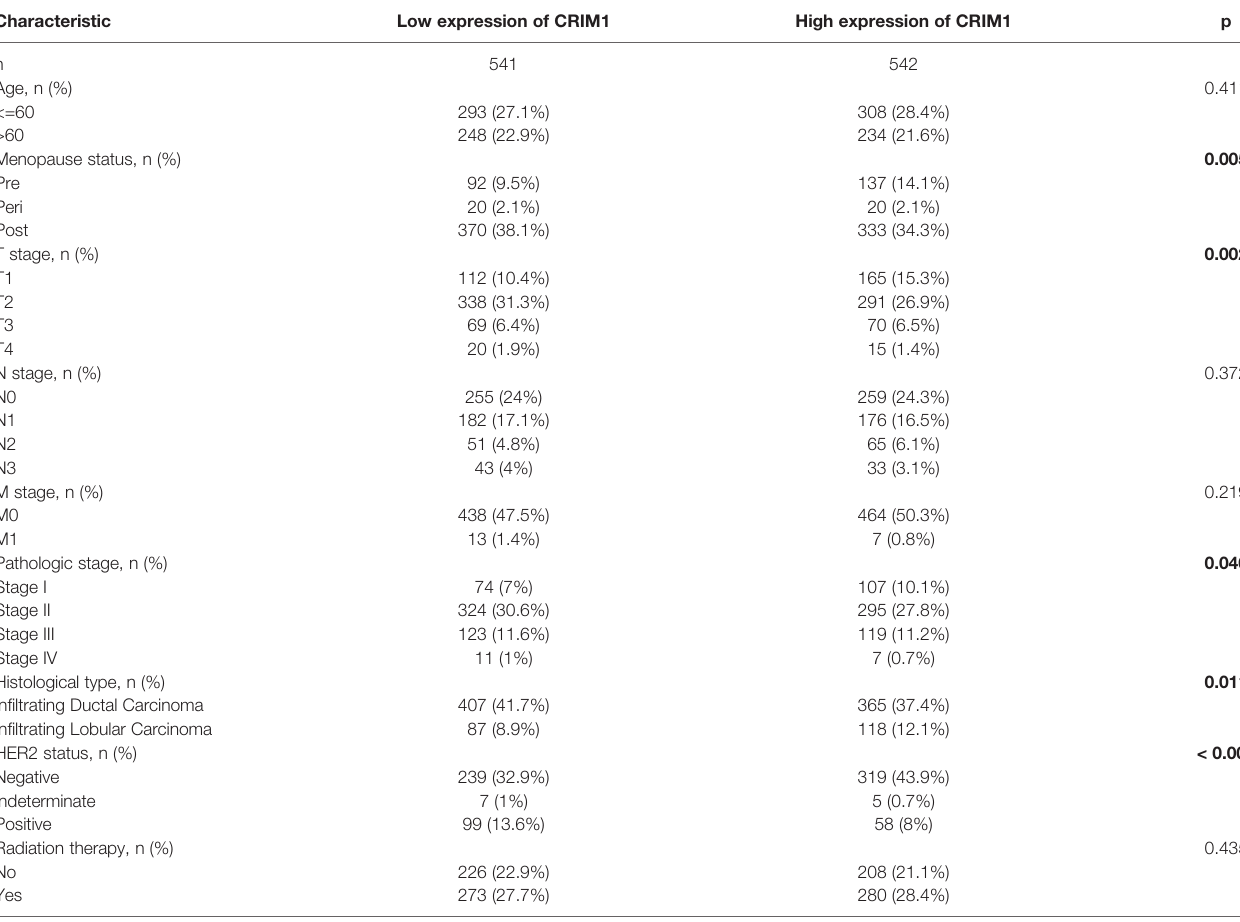
TABLE 3 | Relationship between CRIM1 expression and clinicopathologic parameters of breast cancer patients.